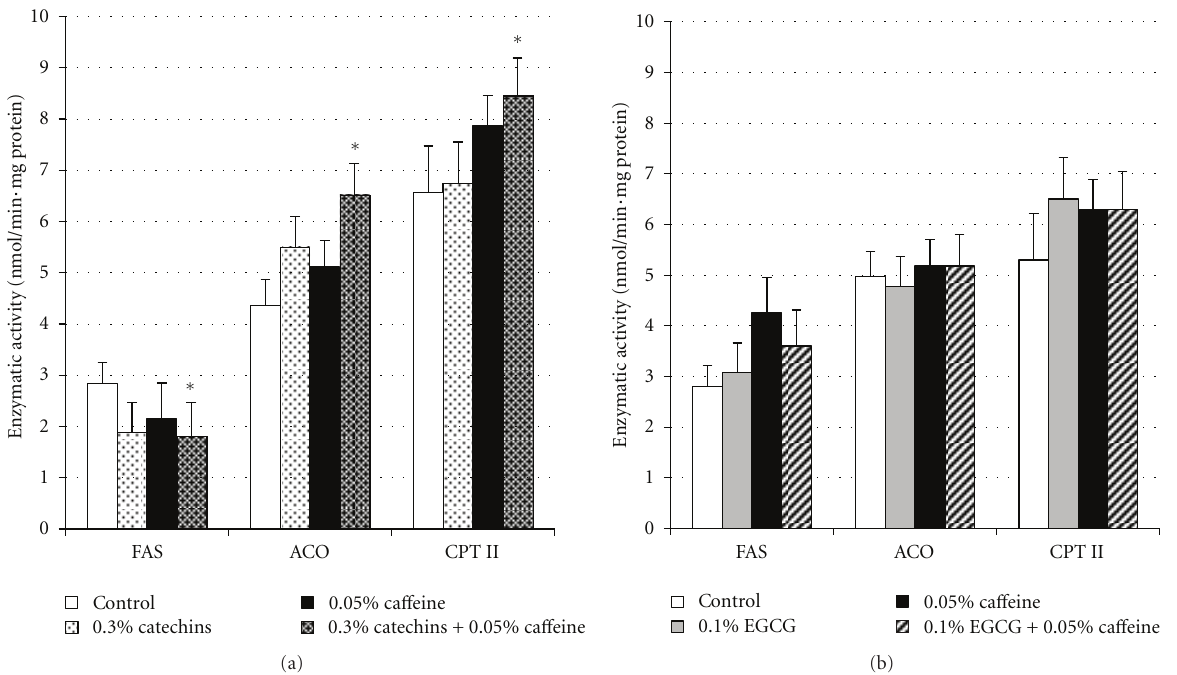
Figure 2: E ff ects of catechins, EGCG, and ca ff eine on enzymatic activity related to lipid metabolism in liver in mice. (a) Enzymatic activity of FAS, ACO, and CPT II in liver in mice fed the diets containing 0.3% catechins, 0.05% ca ff eine, 0.3% catechins + 0.05% ca ff eine for 4 weeks. (b) Enzymatic activity of FAS, ACO, and CPT II in liver in mice fed the diets containing 0.1% EGCG, 0.05% ca ff eine, 0.1% EGCG + 0.05% ca ff eine for 4 weeks. FAS: fatty acid synthase, ACO: acyl-CoA oxidase, CPT II: carnitine palmitoyl transferase II. The means and SE for 10 mice are plotted. ∗ Significant di ff erence compared with the control ( P < 0 .